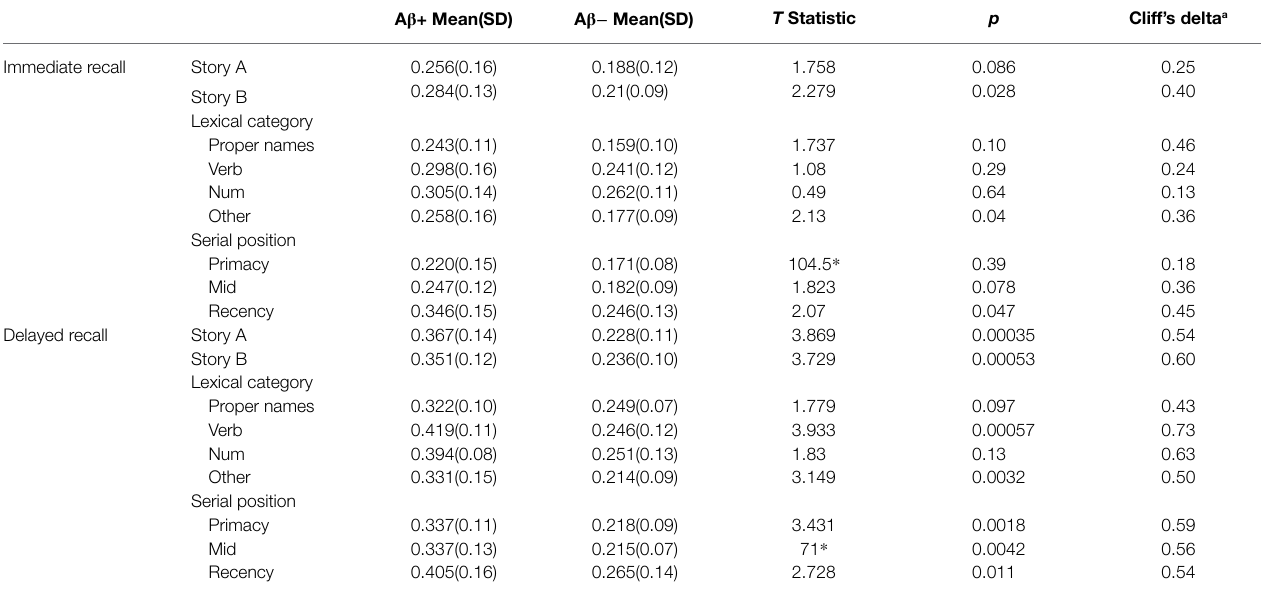
TABLE 5 | The discrimination indices difference between A β + and A β− group for immediate recall and delayed recall by story, lexical category, and serial